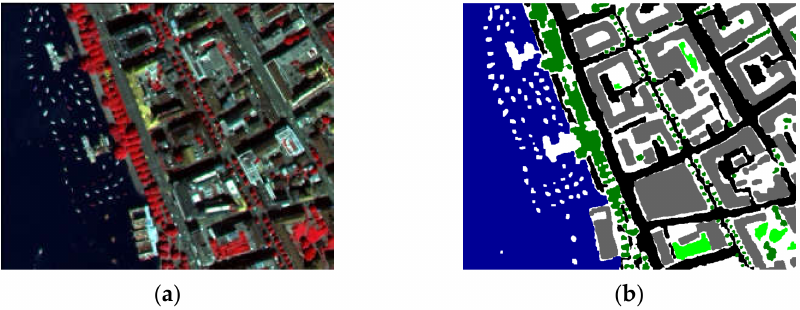
Figure 5. Sample image of Zurich Summer dataset (ZH-12): ( a ) original image; ( b ) ground